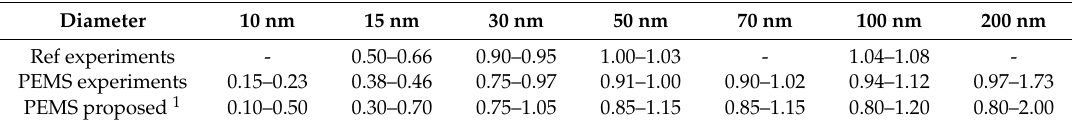
Table 1. Experimental and proposed e ffi